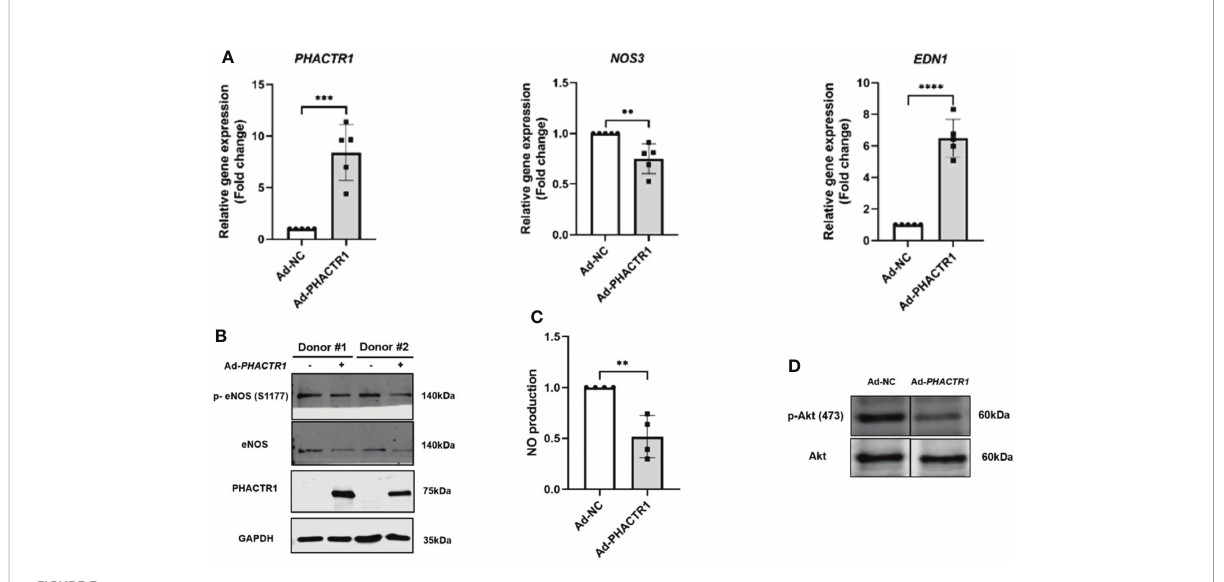
FIGURE 3 PHACTR1 overexpression leads to eNOS downregulation and decreased NO production. (A) PHACTR1 overexpression upregulated EDN1 (also known as ET-1) and downregulated eNOS mRNA expression in HUVECs (n = 5). (B) PHACTR1 overexpression can decrease eNOS total protein and eNOS phosphorylation at Ser1177 (n = 6). (C) PHACTR1 overexpression can reduce NO production in HUVECs (n = 4). (D) PHACTR1 overexpression decreased Akt phosphorylation at Ser473 (n = 3). Lanes presented were spliced from the same blots with uncropped images displayed in online Supplementary Material. **P < 0.01, ***P < 0.001, ***P < 0.0001 ****, P <